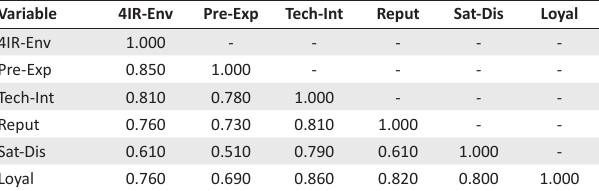
TABLE 4: Inter-correlation matrix.